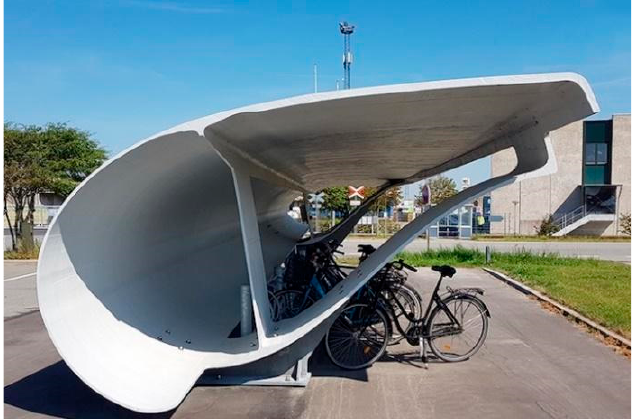
Figure A5. A bike shed in Denmark made from EoL blades [51].